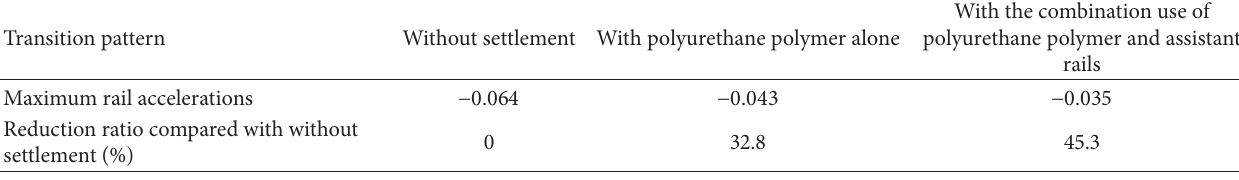
Table 3: Maximum rail accelerations and reduction ratios for different transition patterns.